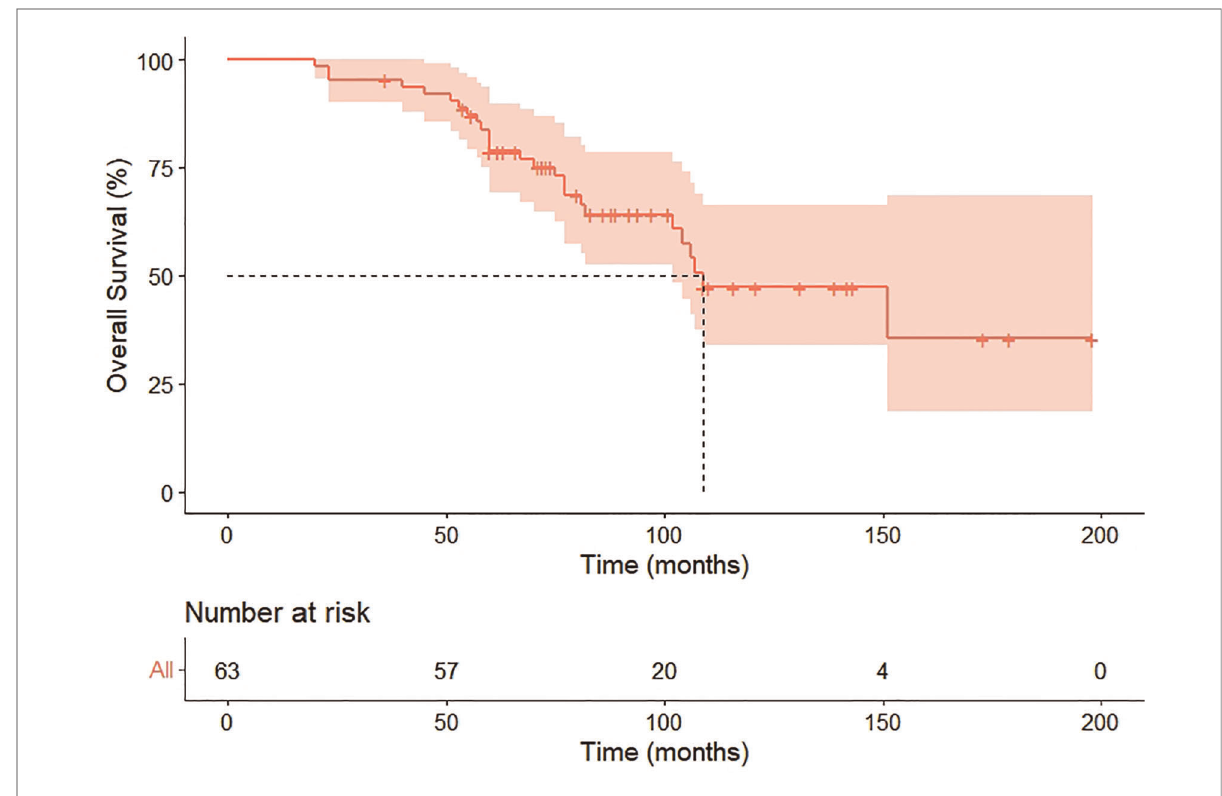
FIGURE 4 Overall survival of enrolled